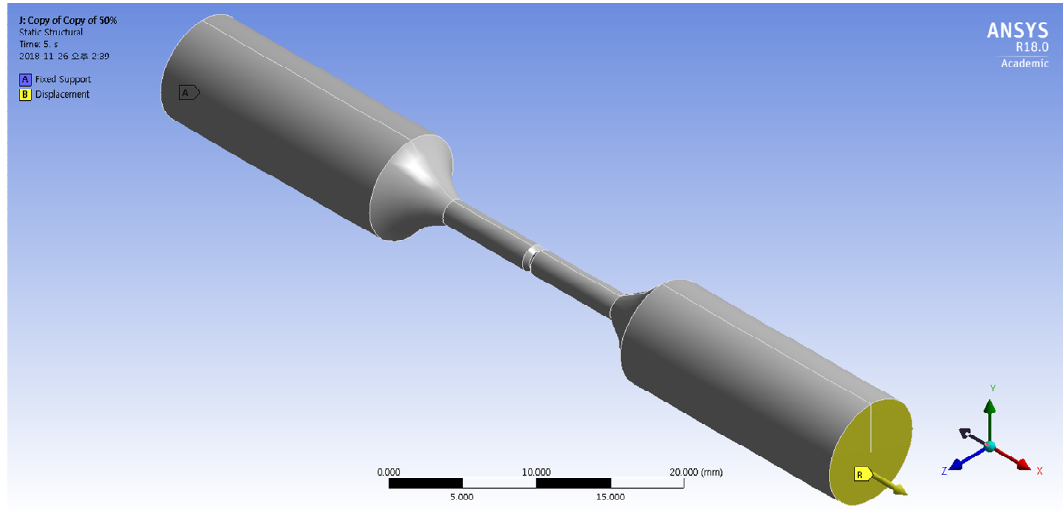
Figure 5. Boundary conditions for finite element method (FEM) simulation of a corroded tensile specimen.